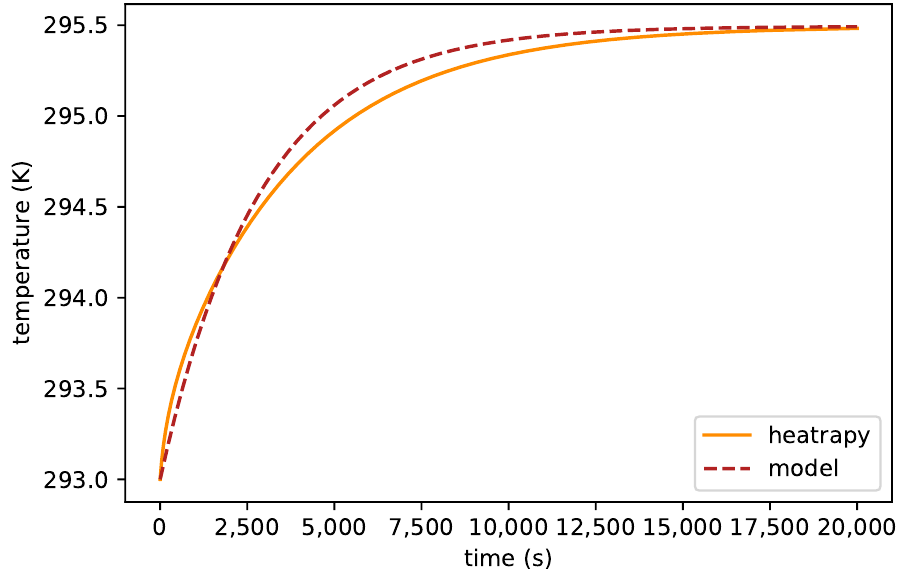
Figure 3. Temperature evolution using the developed model and the heatrapy simulations for a thermal circuit with a single thermal resistance. The used thermal resistance was made of